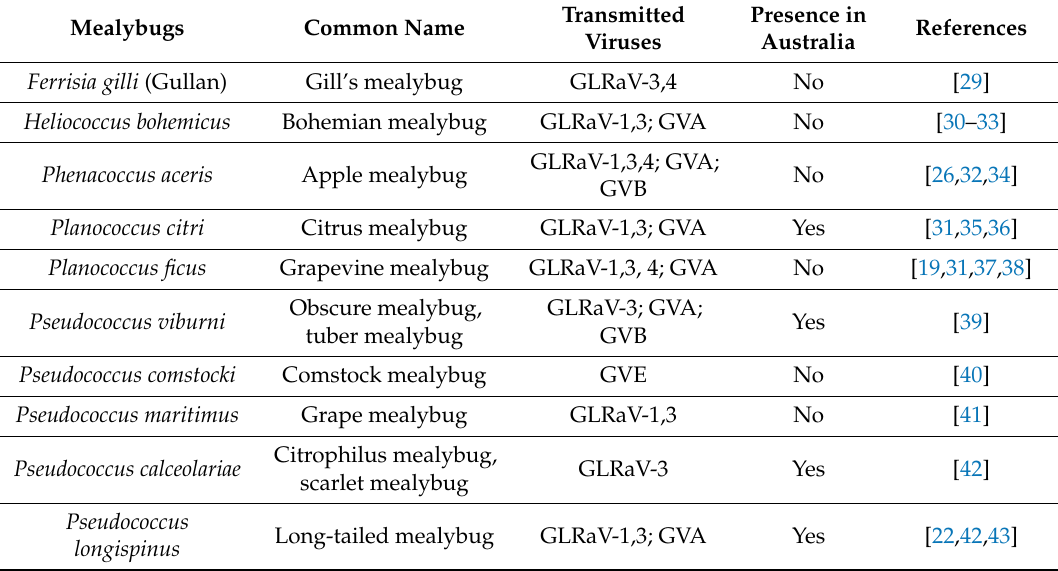
Table 2. Common mealybug vectors of grapevine